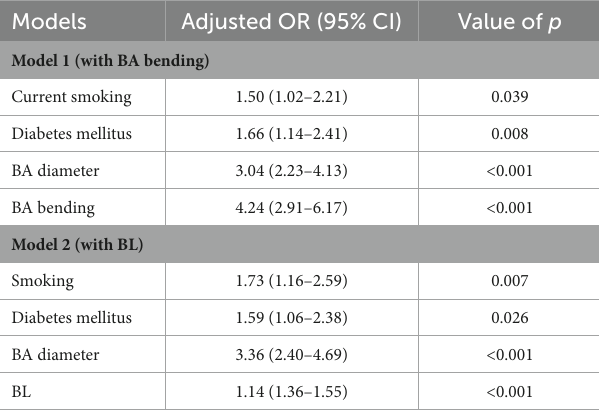
TABLE 2 Multivariate logistic regression analysis of factors associated with BA